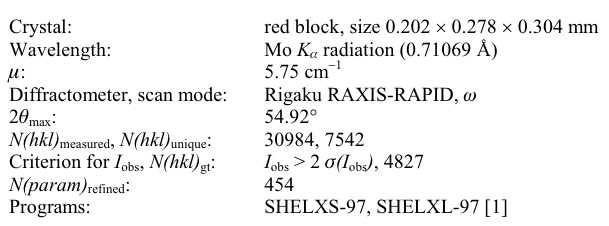
Table 1. Data collection and handling.